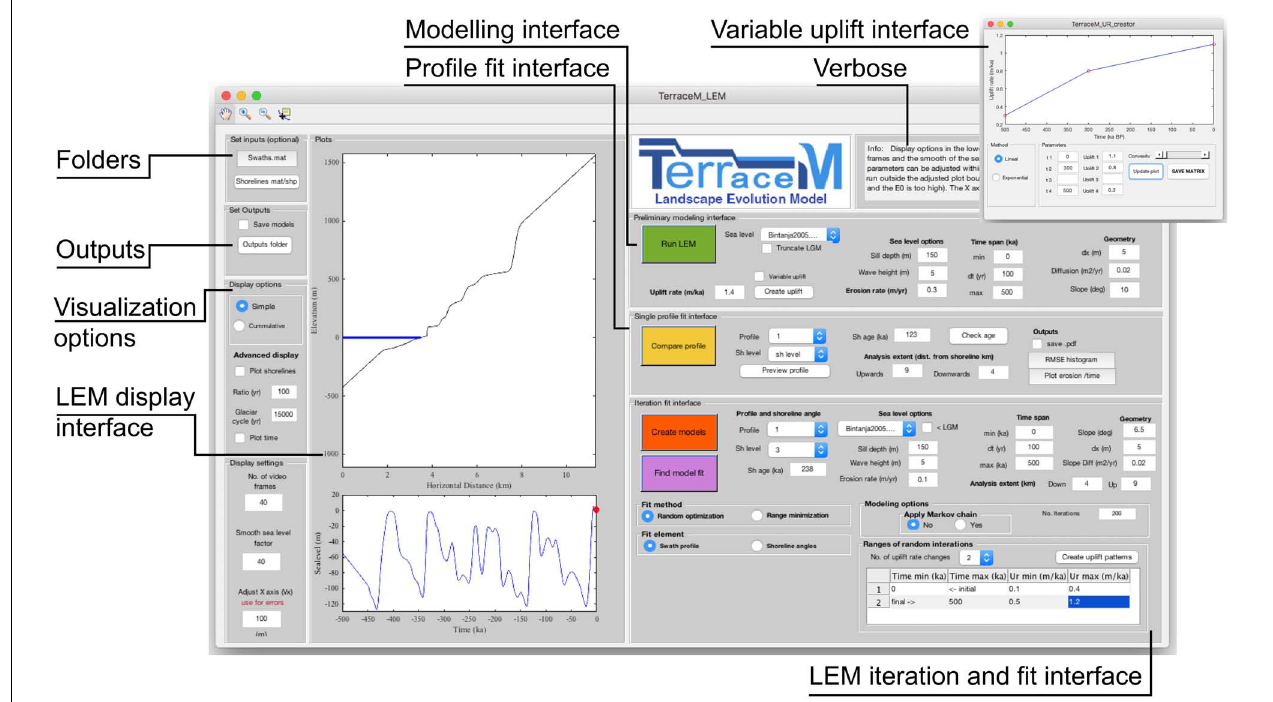
FIGURE 5 | Landscape Evolution Model (LEM)